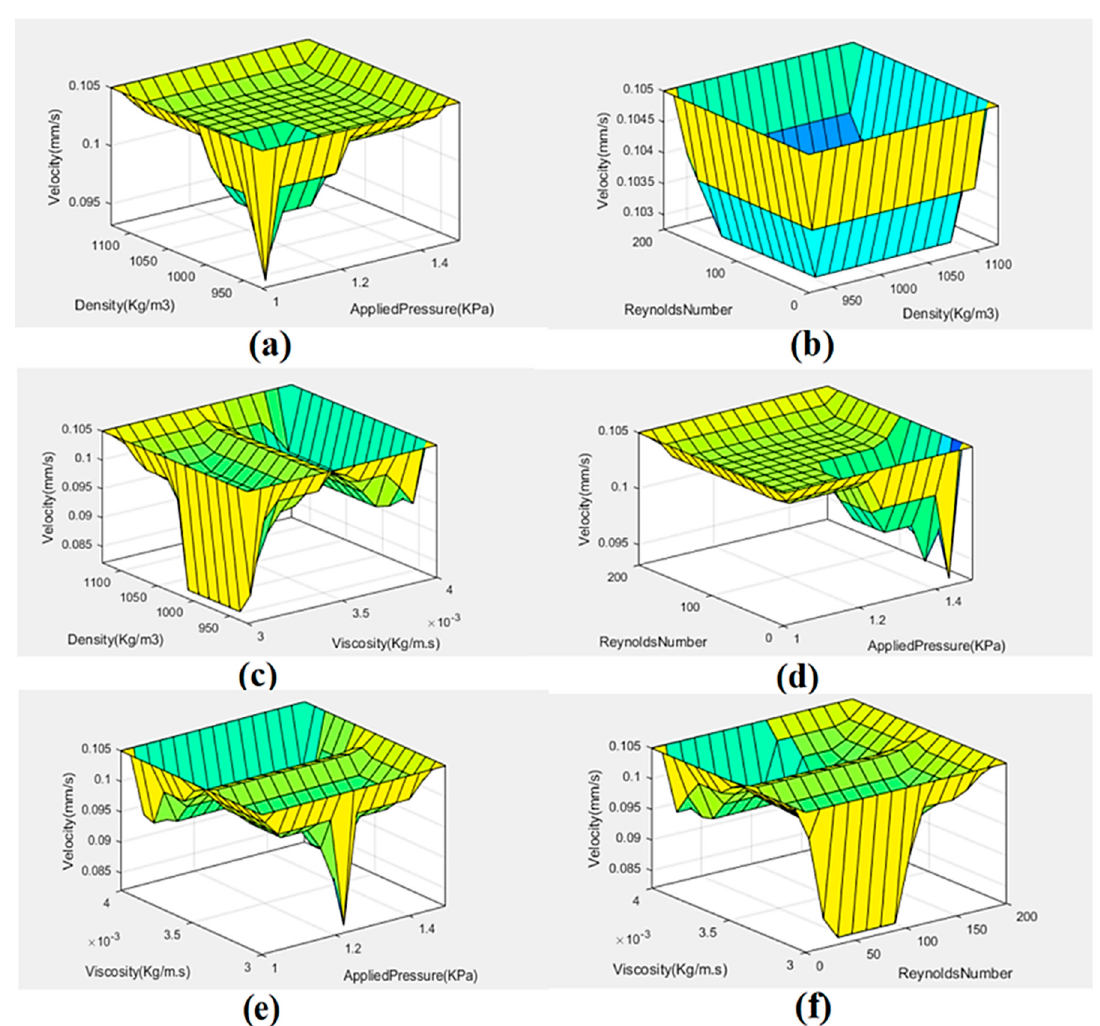
Figure 5. 3D graphical variations with inputs Reynolds number, applied pressure, viscosity, and density with velocity as output. ( a ) Variation for applied pressure with density and velocity as output. ( b ) Variation for Reynolds number with density and velocity as output. ( c ) Variation for viscosity with density and velocity as output. ( d ) Variation for applied pressure with Reynolds number and velocity as output. ( e ) Variation for applied pressure with viscosity and velocity as output. ( f ) Variation for Reynolds number with viscosity and velocity as output. The three-dimensional graphs obtained for 5CACMC from Fuzzy logic simulation with pressure drop as output are shown below in Figure